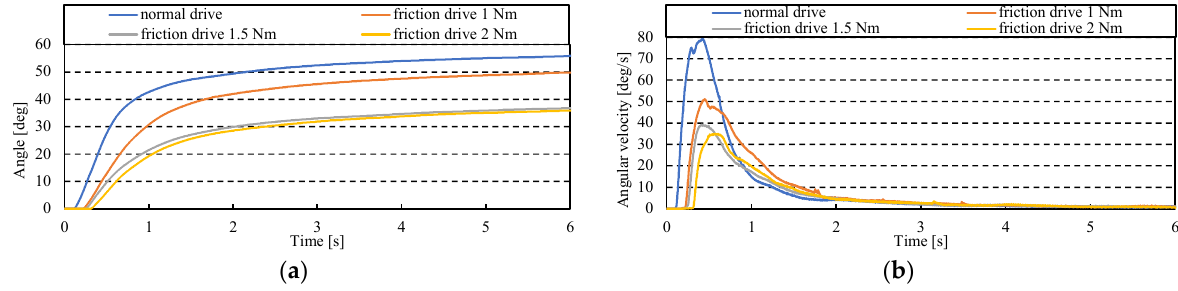
Figure 15. Measurement results of friction drive and normal drive. ( a ) Results of angle. ( b ) Results of angular velocity.